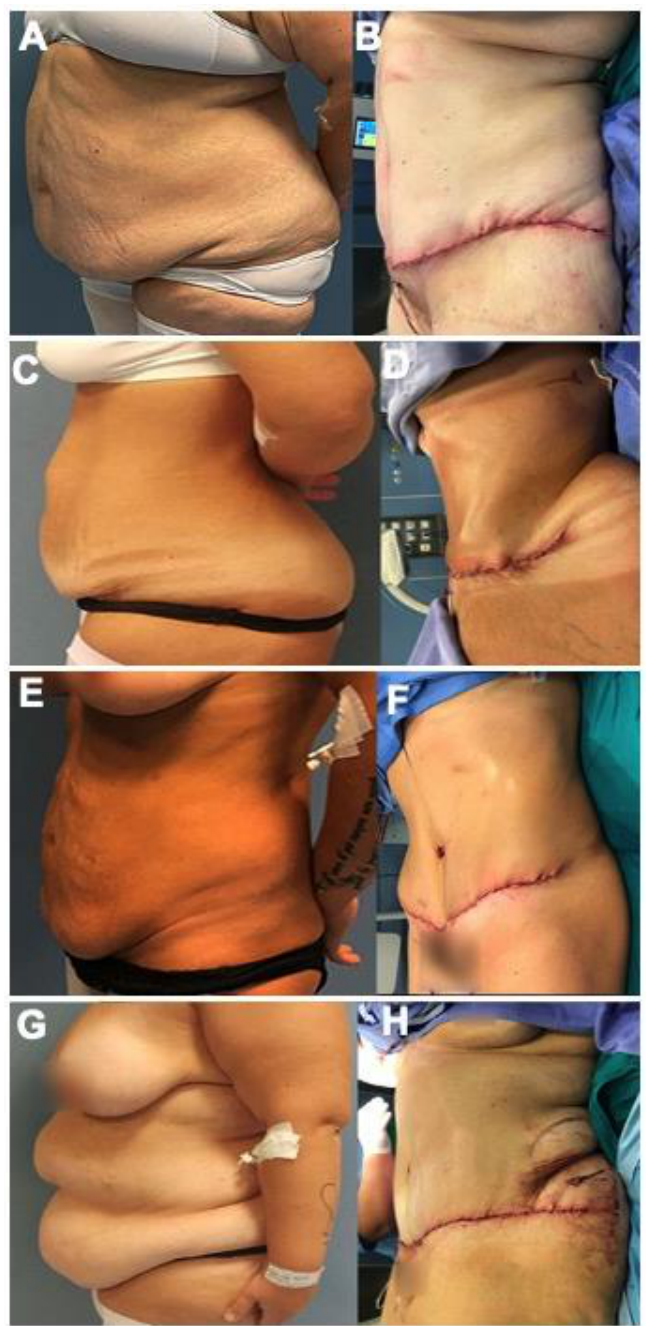
Figure 2. Lateral view: before ( A , C , E , G ) and after ( B , D , F , H ) photos of the patients underwent high superior tension abdominoplasty. ( A , B ): Female, 52 years old, submitted to traditional abdominoplasty after gastric balloon and 19 kg of weight loss. ( C , D ): Female, 39 years old, abdominoplasty and abdominal wall reparation for umbilical hernia after gastric mini-bypass and 26 kg of weight loss. ( E , F ): Female, 40 years old, abdominoplasty after sleeve-gastrectomy and 32 kg of weight loss. ( G , H ): Female, 50 years old, lipo-abdominoplasty after sleeve-gastrectomy and 49 kg of weight loss.